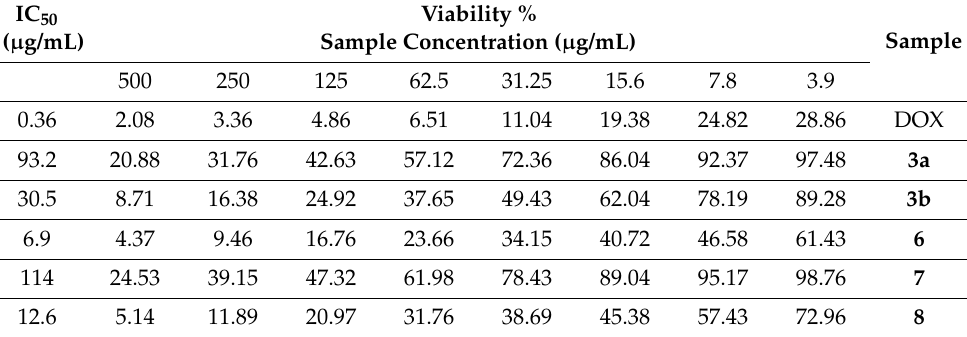
Table 2. Viability values and IC 50 of some selected samples against hepatocellular carcinoma cell line (HepG-2).